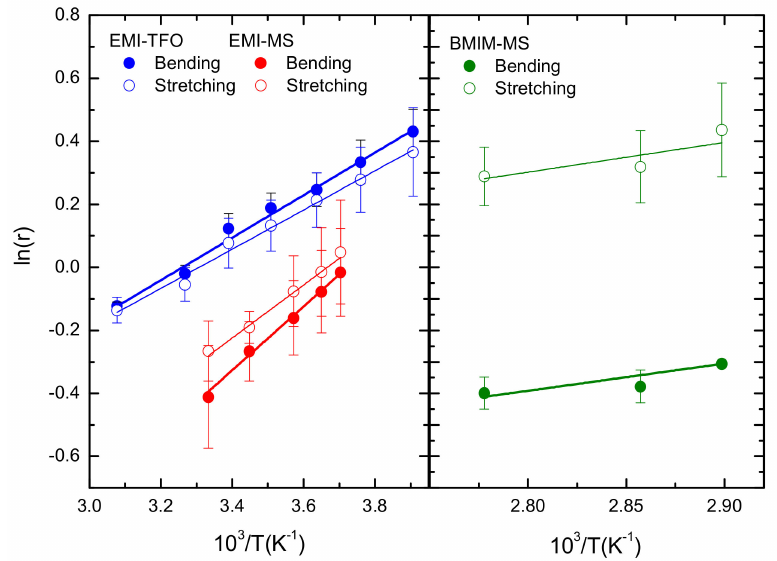
Figure 8. Logarithm of the ratio of intensities of hydrogen-bonding band to the dispersion-governed configurations band and best fit lines, as a function of temperature. EMI-TfO: blue circles;EMI-MS: red circles; BMIM-MS: green circles. Full symbols refer to ratio obtained considering the bending modes for the hydrogen bond-governed configurations, open symbols refer to ratio obtained considering the stretching